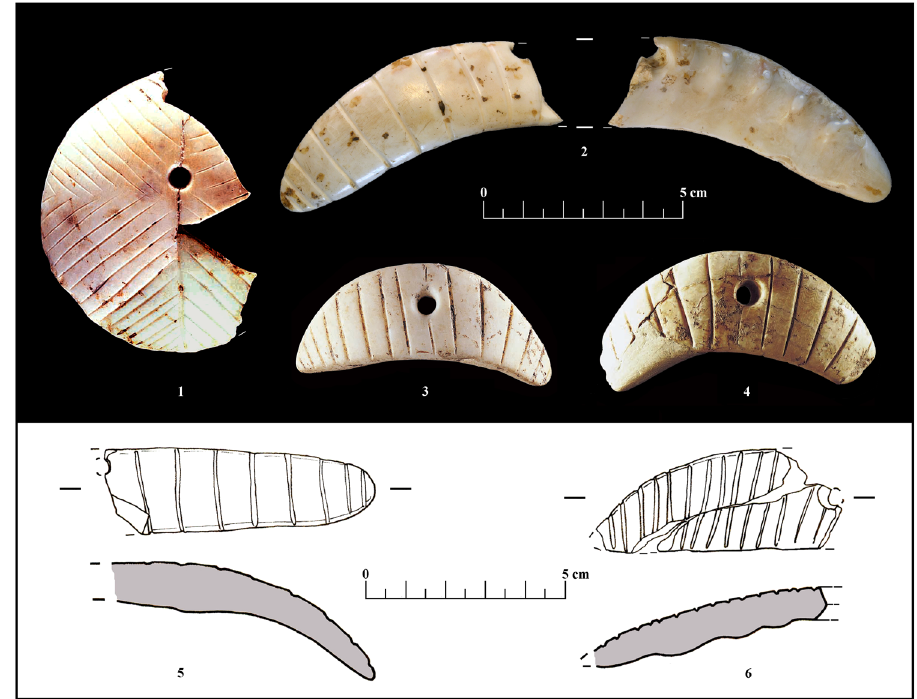
Figure 7: Arene Candide Cave: ( 1 ) Glycymeris shell pendant; ( 2, 5 and 6 ) Charonia shell pendants; ( 3 and 4 ) Spondylus shell pendants; ( 1, 3, 5 and 6 ) from the 19th century investigations; ( 2 ) impressed Ware horizon of excavations 1997 – 2012; ( 4 ) Impressed Ware horizon, layer 26C from the excavations of Luigi Bernabò Brea (( 1 and 3 ) after Borrello, 2005; ( 2 ) after Micheli et al., in press; ( 4 ) after Micheli, 2005; ( 5 and 6 ) drawings R. Micheli; courtesy Genova - Pegli Museum of Ligurian Archaeology )